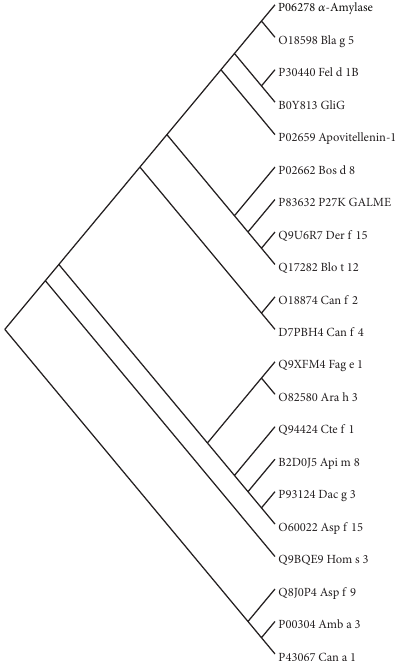
Figure 4: Maximum Parsimony Tree of 21 representative allergens reduced from the allergens corresponding to 534